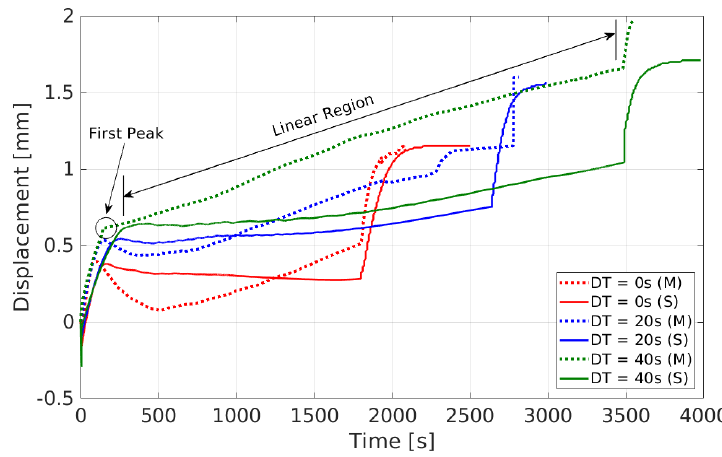
Figure 10. Comparison of distortions. Table 3. Comparison of distortion (computed values given in brackets).